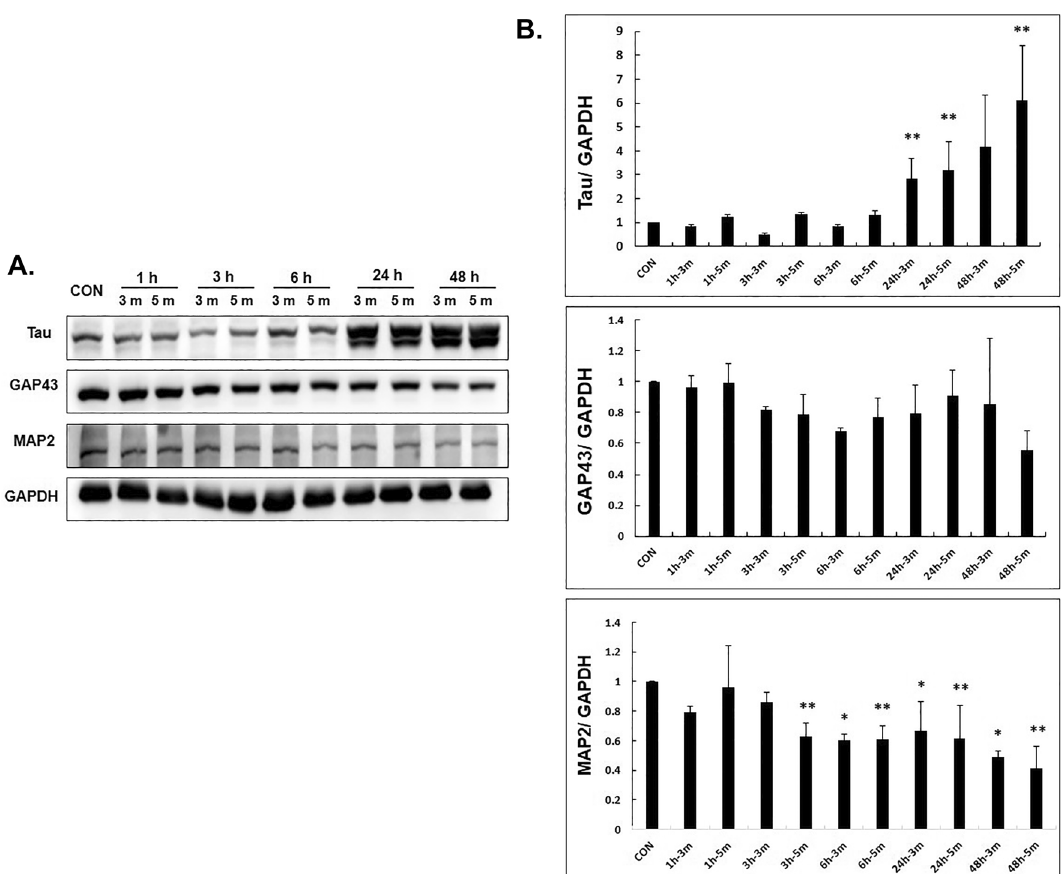
Figure 3. Western blotting of SH-SY5Y cell extracts. GAPDH was used as a loading control. The expression of tau increased significantly after 24 h of NTP treatment. The expression of GAP43 showed no significant difference, while the expression of MAP2 decreased significantly after 3, 6, 24, and 48 h of NTP treatment. *Indicates p < 0.05, ** indicates p <